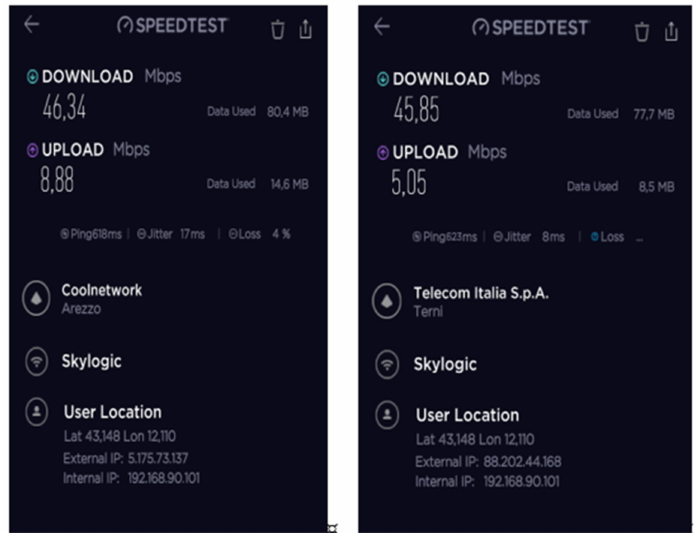
Figure 18. B-LiFE deployment in Turin, Italy, during the COVID-19 crisis: speed test results for the Eutelsat SatCom kits 1 and 2.